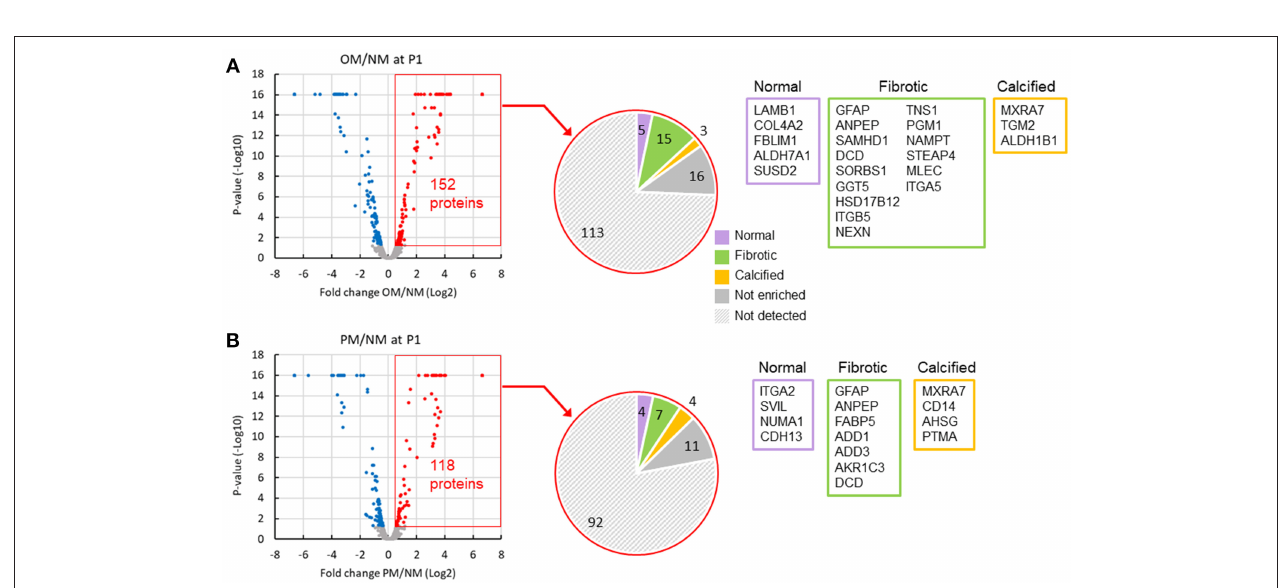
FIGURE 4 | Comparison of VIC and valve tissue proteomics datasets indicated some shared regulated proteins. Volcano plots of increased (red) and decreased (blue) passage one VIC proteins in OM (A) and PM (B) after 2 weeks in culture. Comparison of increased VIC proteins (152 in OM and 118 in PM) to valve tissue disease stage proteomics dataset shown in pie charts. List of gene names for proteins increased in OM or PM, which were also found to be enriched in normal (purple box), fibrotic (green box), and calcified (orange box) human aortic valve tissues. Not enriched indicates proteins increased in VICs that were not found to be enriched in any of the three valve tissue disease stages. Not detected indicates proteins not detected in the untargeted valve tissue proteomics dataset; n = 4 VIC donors and 9 human valve tissue